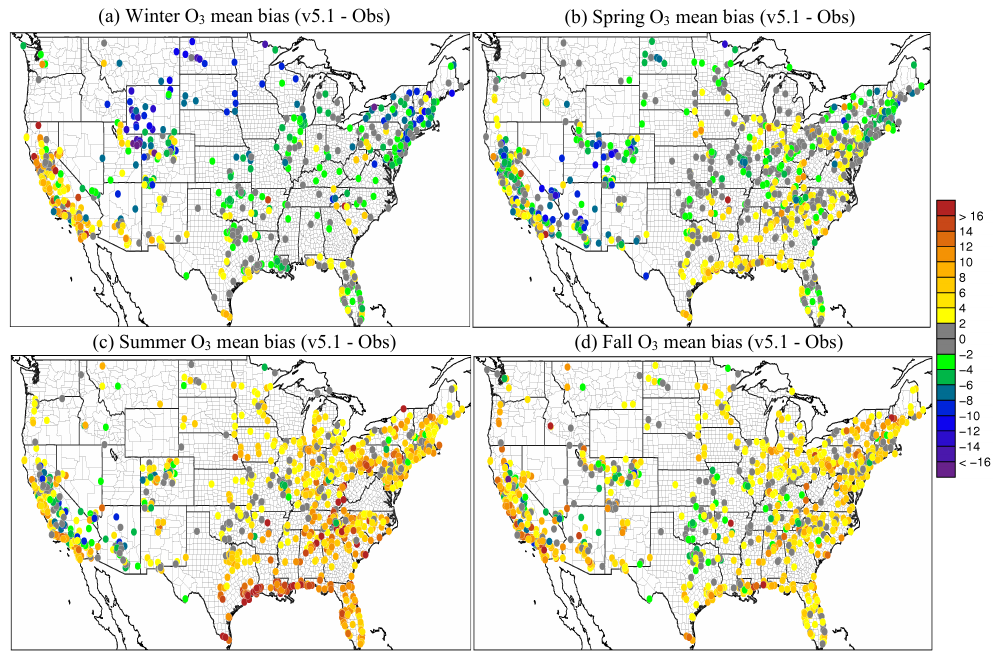
Figure 12: Seasonal average hourly O 3 mean bias at AQS sites for a) winter (DJF) b) spring (MAM) c) summer (JJA) and d) fall (SON) for the CMAQ v5.1_Base simulation. All plots are in units of ppbV. Figure 12. Seasonal average hourly O 3 (ppbv) mean bias at AQS sites for (a) winter (DJF), (b) spring (MAM), (c) summer (JJA) and (d) fall (SON) for the CMAQv5.1_Base_NEIv1 simulation.